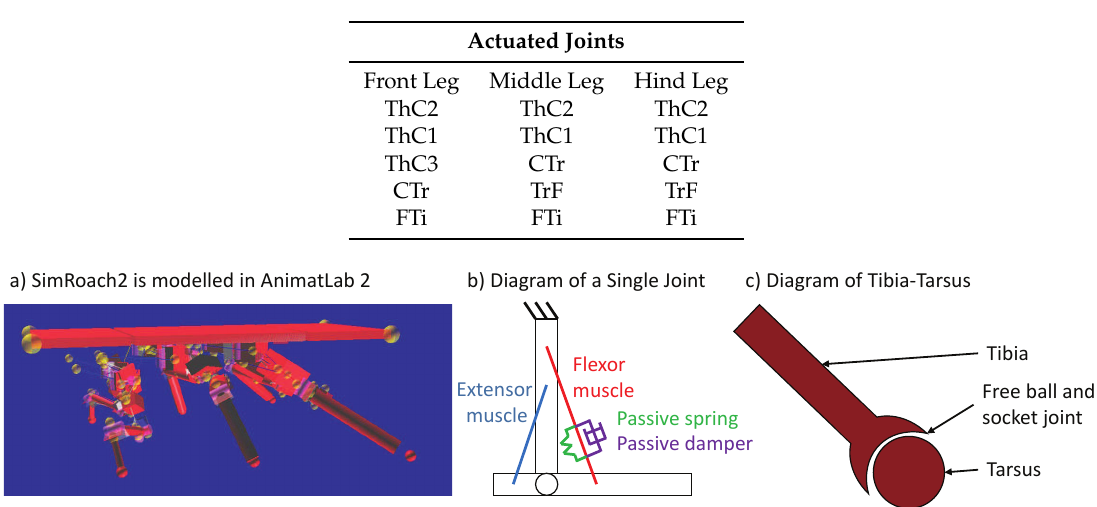
Table 1. Actuated joints in each leg starting from the joint closest to the body and moving distally outward. Thorax-coxa (ThC) joints act between the thorax and the coxa. Coxa-trochanter (CTr) joints act between the coxa and the trochanter. Trochanter-feumr (TrF) joints act between the trochanter and the femur. Femur-tibia (FTi) joints act between the femur and the tibia.